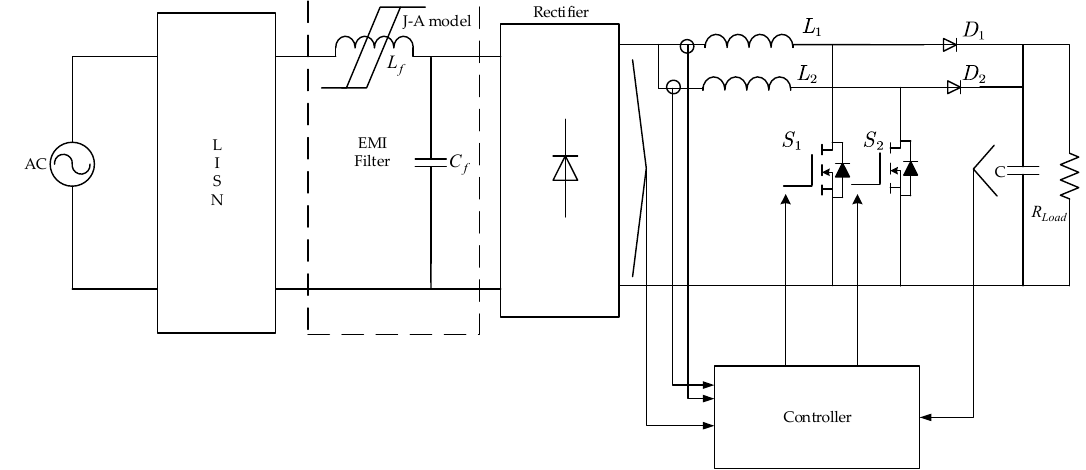
Figure 5. Configuration of the simulated PFC block.